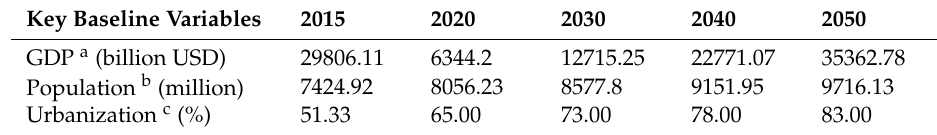
Table 2. The key baseline variables in the LEAP-Hebei model.